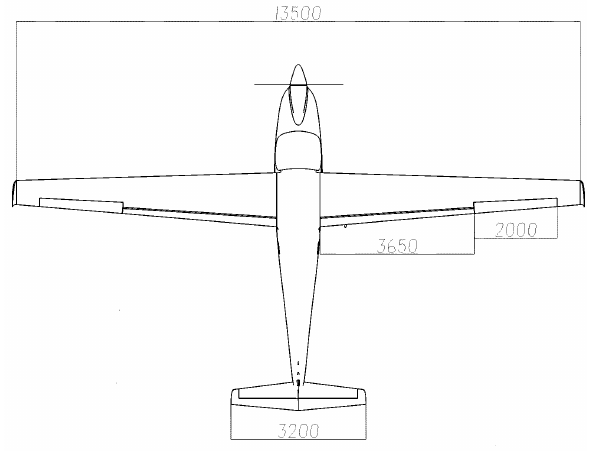
Figure 1: Outline dimension diagram of aircraft